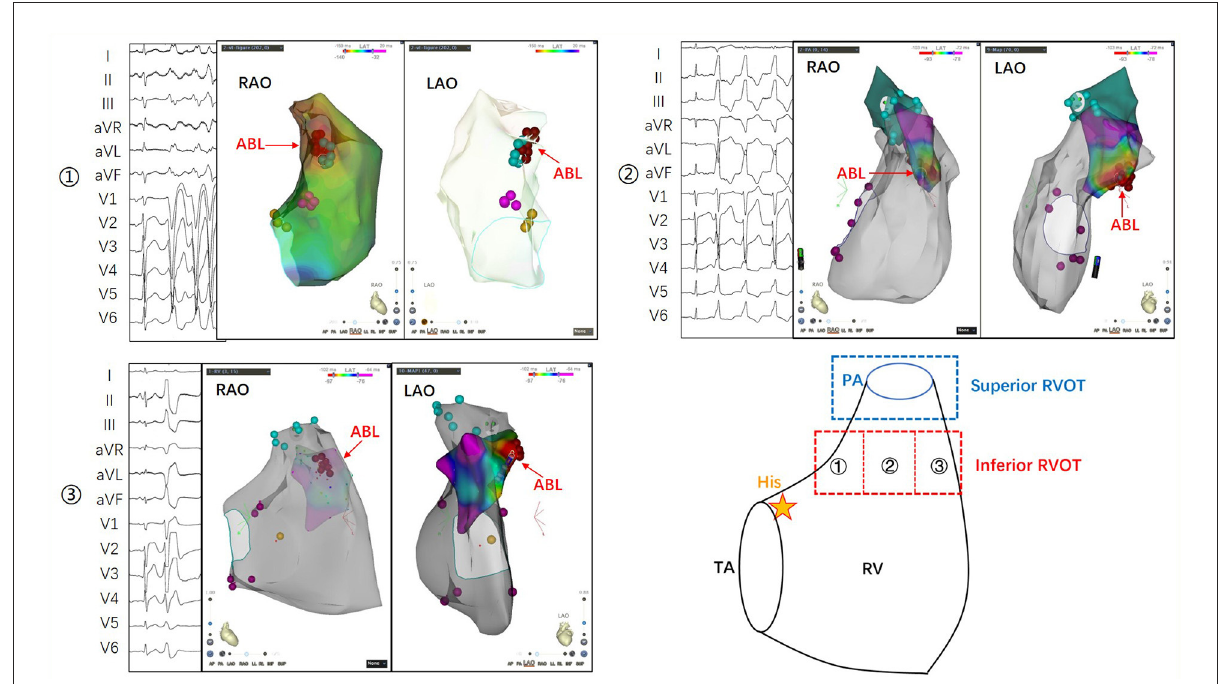
FIGURE3 The inferior RVOT is between the supraventricular crest above the tricuspid annulus and the pulmonary annulus. Its lower portion is flush with His bundle, and its upper portion is more than 1cm lower than the pulmonary annulus. ‹ The morphological characteristics of PVCs originating from the inferoposterior RVOT include a more comprehensive QRS, an R/S shape in leads II, III, and aVF, a positive main wave in leads I and aVL, and a shift in the R/S transition to between V4 and V5. › The morphological characteristics of PVCs originating from the inferomedial RVOT include an upright but not tall QRS in leads II, III, and aVF, opposite main waves in leads I and aVL, and a shift of the R/S transition to between V3 and V4. fi The morphological features of PVCs originating from the inferoanterior RVOT include an upright QRS in leads II, III, and aVF, and a negative main wave in leads I and aVL, indicating the origin of the septum. V1–V3 is QS-shaped, the beginning of the QRS in lead V1 is similar to the preexcitation wave, and the R/S transition is shifted to lead V5. PA, pulmonary artery; RAO, right anterior oblique; RV, right ventricle; RVOT, right ventricular outflow tract; TA, tricuspid